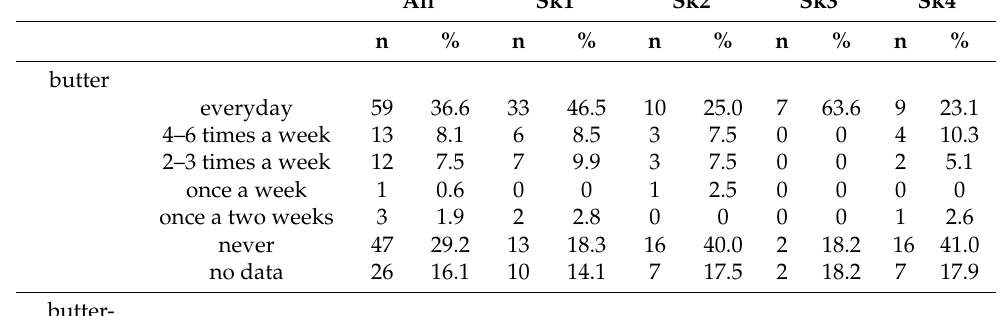
Table A3. Consumption of fats among investigated patients.